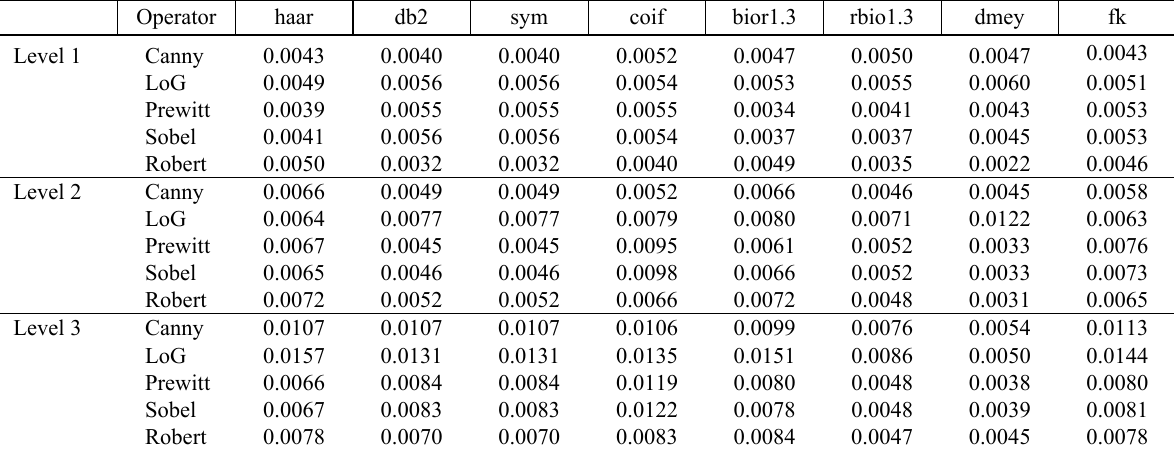
Table 8. F-measure values for different edge detection operators and wavelet transformations for an image with LD